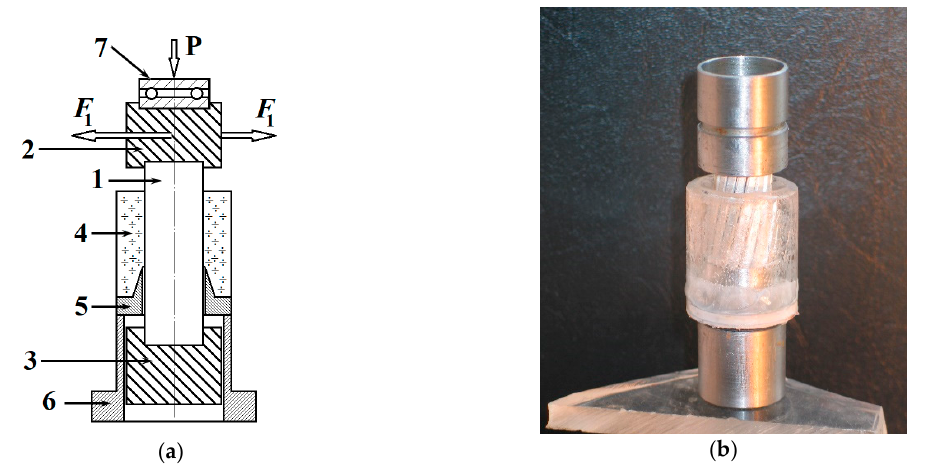
Figure 8. ( a ) Scheme of the device for testing ice adhesion to electric cables in conditions of combined shear [100]. 1 — test sample; 2 and 3 — clutches; 4 — ice sleeve; 5 — tapered bushing; 6 — support bushing; 7 — flat ‐ thrust bearing; P — applied axial load; F1 ‐ F1 — pair of forces applying a torsion torque; ( b ) Photo of the ice sleeve on the electric cable clamped between two clutches.